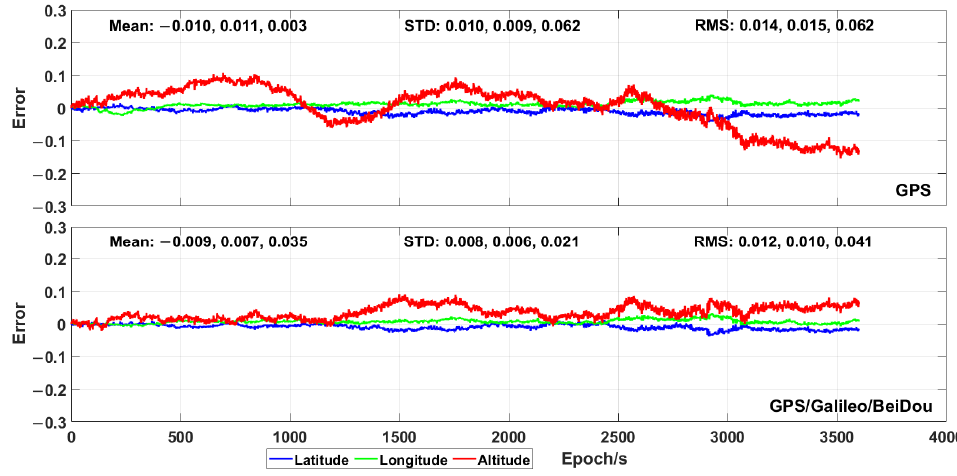
Figure 15. Positioning error obtained by means of the proposed time-relative positioning method during the dynamic test.